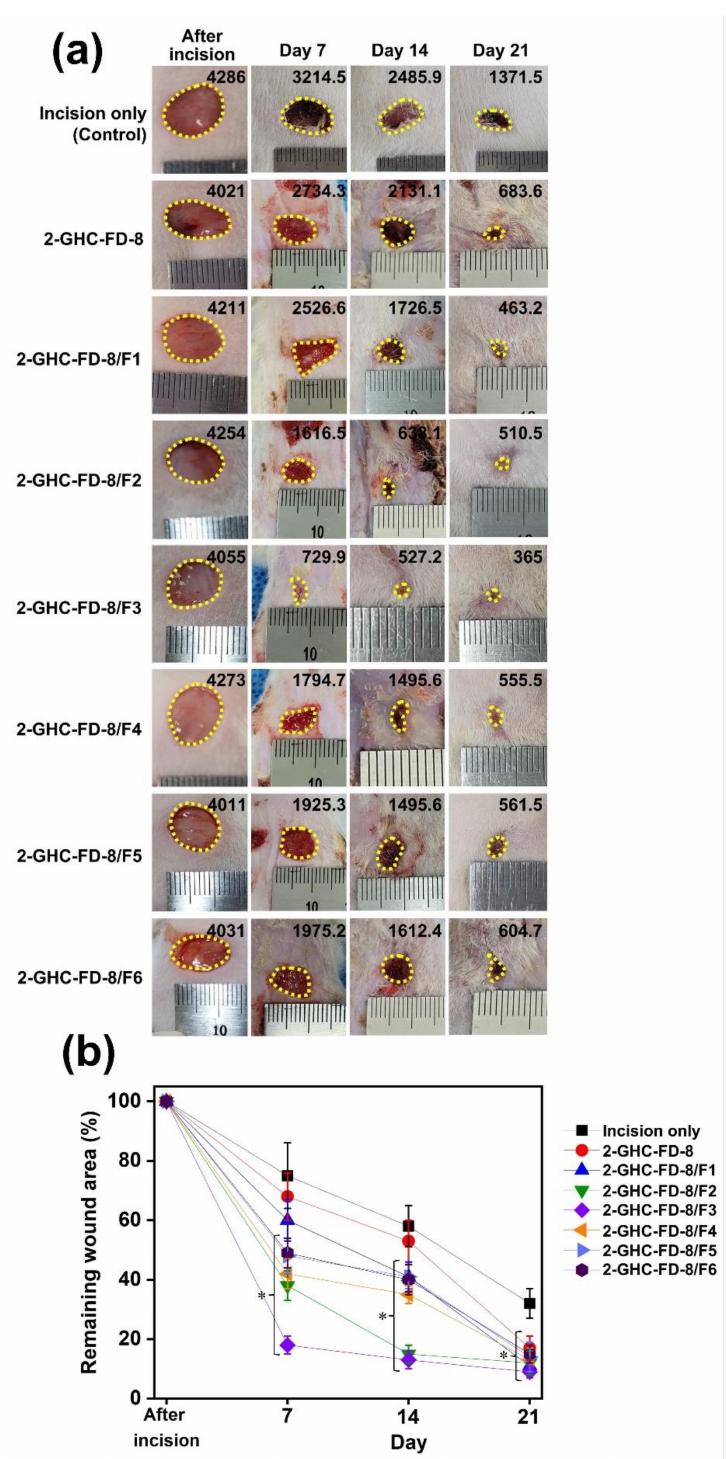
Figure 10. ( a ) Macroscopic appearances; and ( b ) remaining area of wounds treated with 2-GHC-FD-8 and 2-GHC-FD-8/F1-6 for 7, 14, and 21 days. In each photo, the black-colored number of upper-right indicates were calculated by an Image J program, indicating the area of remaining wounds. In ( b ) graph, the statistical significance was indicated by an asterisk (*) for p < 0.05. The results of the FD samples were compared to that of incision only. The type of this result is involved in continuous